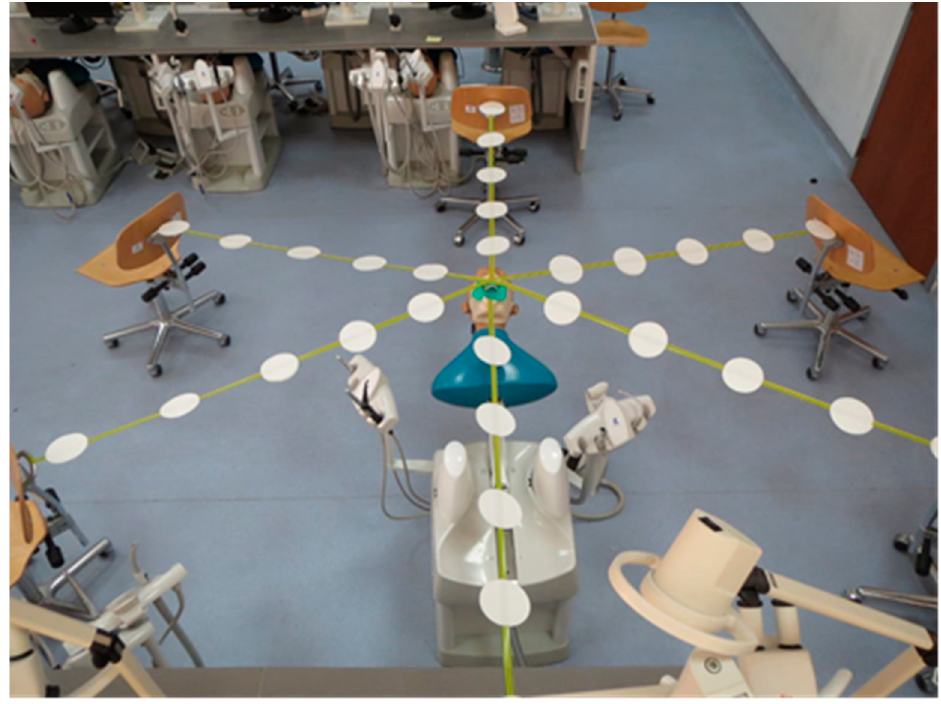
Figure 2. Distribution of filter papers around the dental manikin at different positions and dis- tances.